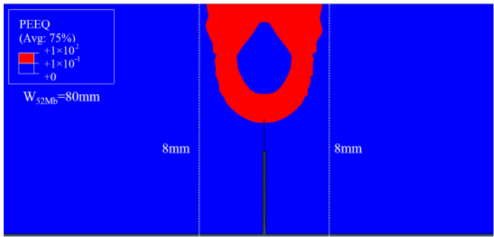
Figure 6. The distributions of ε p = 0.1 isoline at crack tip at J = 1600 kJ/m 2 .